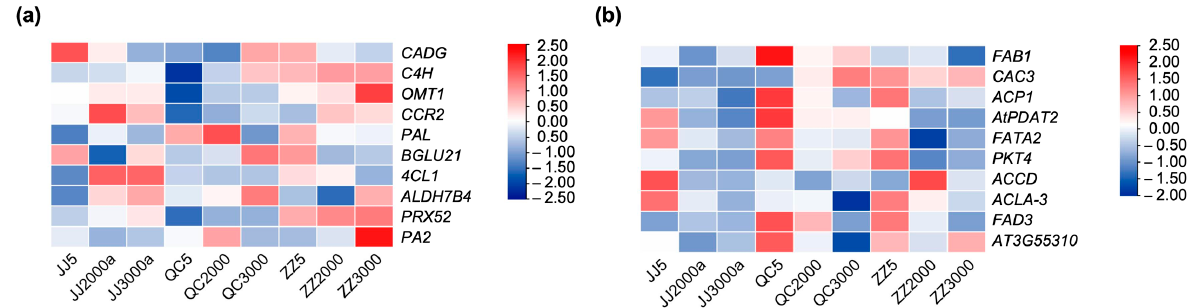
Figure 7. The changes in expression levels of the hub genes of module green ( a ) and module black